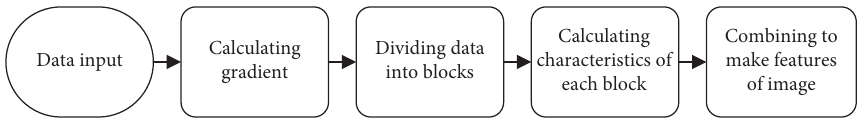
Figure 2: Proposed gesture recognition